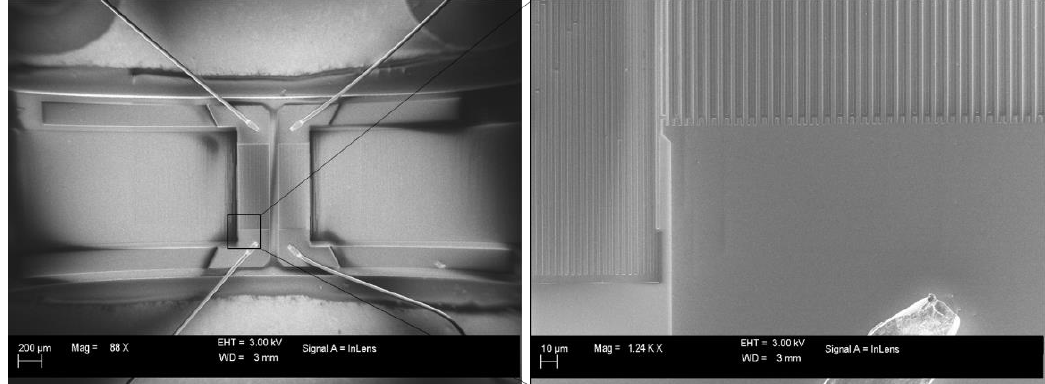
Figure 1. Two SEM micrographs of an R2630 SAW resonator working at 418.05 MHz: ( left side ) overview and ( right side ) particular magnification.